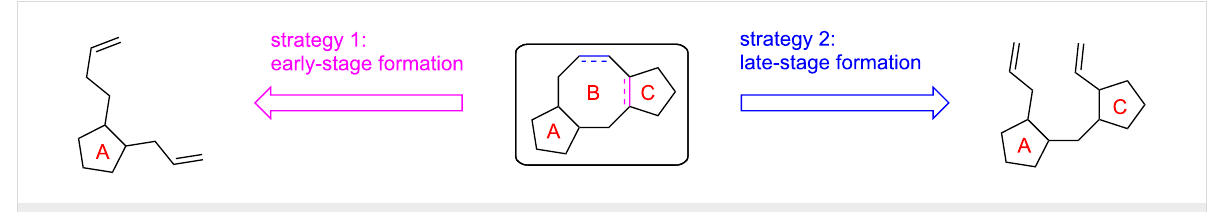
Figure 3: Examples of strategies to access the fusicoccan and ophiobolin tricyclic core structure by RCM.